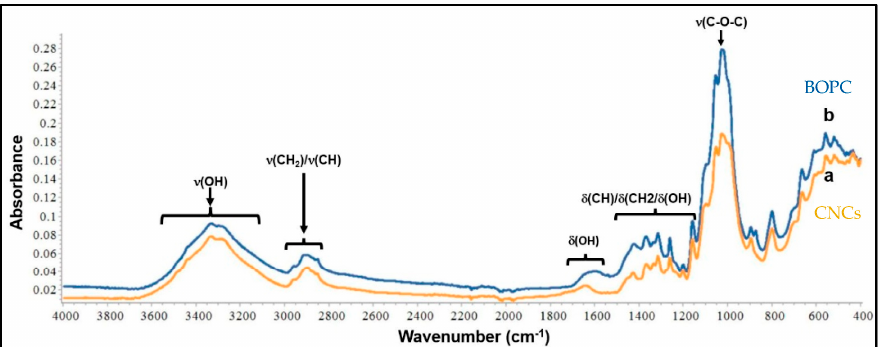
Figure 6. ATR/FT − IR spectra of (a) bleached orange peel cellulose (BOPC) and (b) cellulose nano- crystals (CNCs) with the assignment of the most prominent absorption bands.